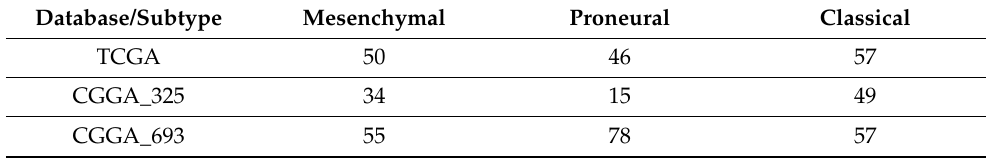
Table 4. Number of included GBM samples of different molecular subtypes according to